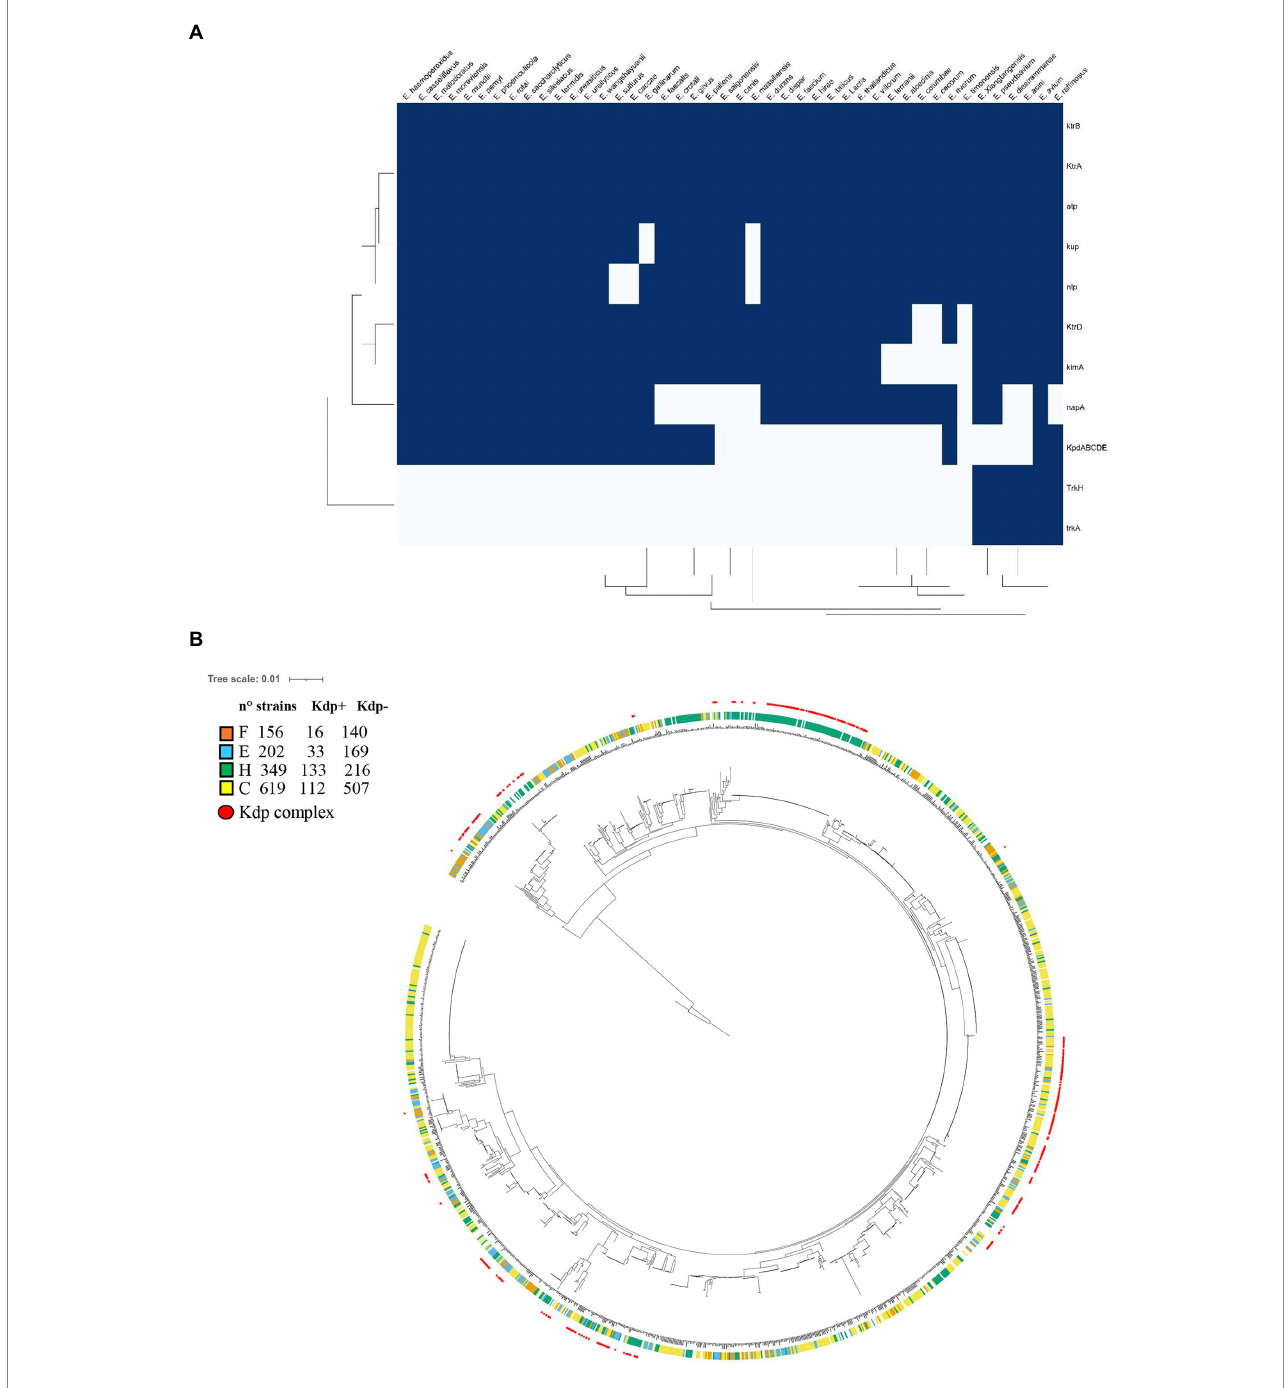
FIGURE 6 (A) Heatmap showing the presence of K + transporters and related ATPases in Enterococcus species. A presence-absence matrix was constructed and Distance-based clustering was applied. Dark blue indicates presence of the genes analyzed. (B) Analysis of the presence of kdp genes and the phylogenomic relationships among E . faecalis members. 34 common ancestral genes were individually aligned, concatenated, and trimmed resulting in a final alignment containing a total of 4,726 residues. The evolutionary history of the 1,510 E . faecalis members was inferred with RAxML algorithm (Stamatakis, 2014) and displayed and annotated using iTOL (Letunic and Bork, 2011). The inner circles colors indicate the source of isolation; F, food (orange); C, commensal (yellow); E, environmental (light blue); and H, clinical (green). The red outside circles indicate the presence of the kdp genes within the